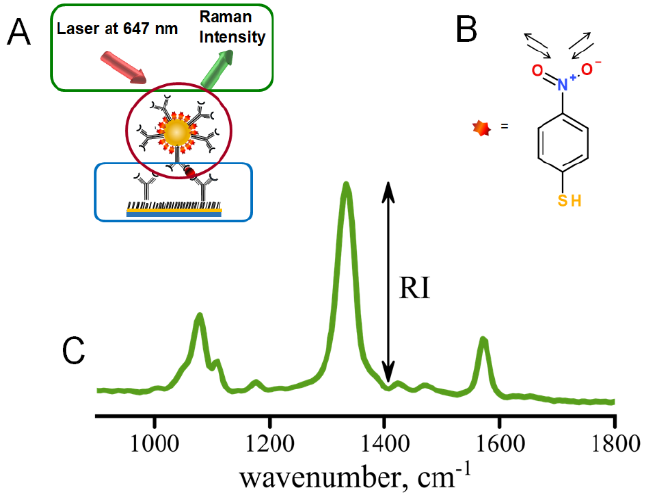
Figure 2. ( A ) Sandwich immunoassay involving capture substrate modified with specific antibodies (blue), Raman tags (modified AuNPs) to carry secondary antibodies (red), excitation and data collection provided by the mRR (green); ( B ) structure of the NBT reporter molecule with intense Raman band characteristic of nitro stretch—at 1336 cm − 1 ; ( C ) typical Raman spectrum observed for immunoassay using NBT-modified AuNPs as Raman tags.